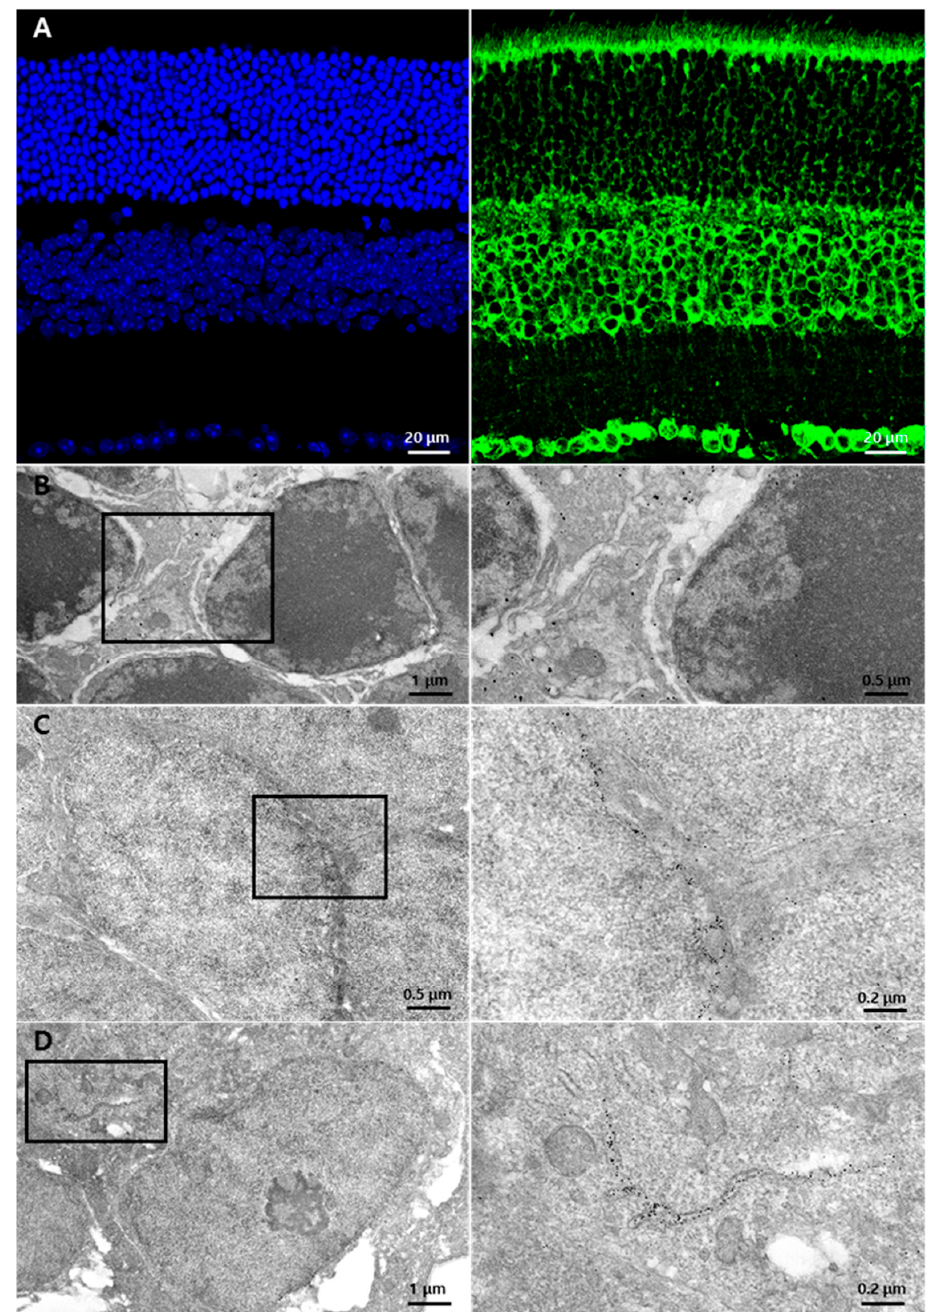
Figure 1. GRP78 expression in normal retinas: ( A ) Representative normal retina labeled with DAPI (blue) and GRP78 (green). GRP78 was mainly labeled in the rod and cone layers and the cell bodies of the INL and GCL. In the ONL, the photoreceptor cell bodies were weakly surrounded by GRP78. ( B – D ) Representative EM images of the normal retina with immuno-gold-labeled GRP78. ( B ) Normal photoreceptor cells in ONL. Immuno-gold labeled-GRP78 was detected in the interspace of the photoreceptor cell bodies but not in the photoreceptor cells. ( C ) Cell bodies in INL. Immuno-gold-labeled GRP78 was detected in the perinuclear spaces of INL cells. ( D ) Representative EM images of GCL. Immuno-gold-labeled GRP78 was detected in the perinuclear spaces and ER lumen of the GC. INL, inner nuclear layer; GCL, ganglion cell layer; ONL, outer nuclear layer; EM, electron microscopy; ER, endoplasmic reticulum; GC, ganglion cell.